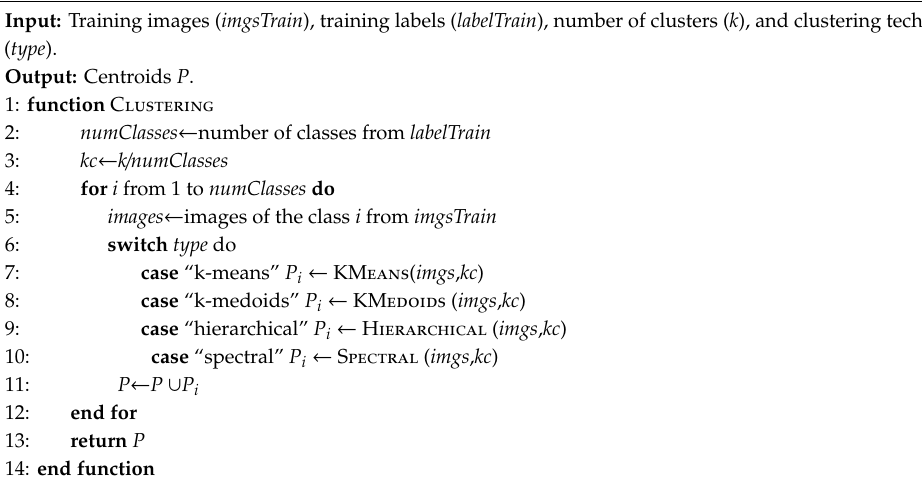
Algorithm 4. Clustering pseudocode